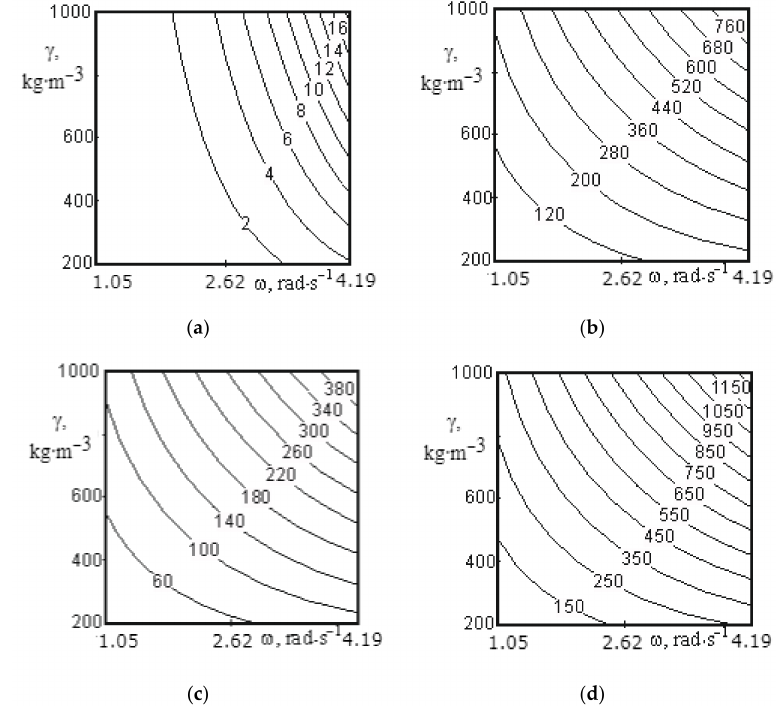
Figure 11. Dependence of the power value on the speed of mixer shaft rotation and the material density for the middle screw: ( a ) the surface constructed based on calculations on the first component; ( b ) the surface constructed based on calculations on the second component; ( c ) the surface constructed based on calculations on the third component; ( d ) the surface representing the change in the total power value for all three components.